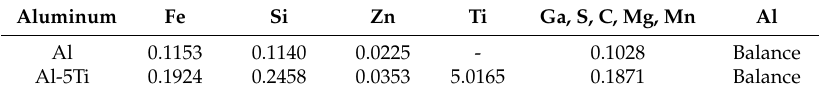
Table 1. Chemical composition of the commercial pure Al and Al-5Ti alloys (wt.%).